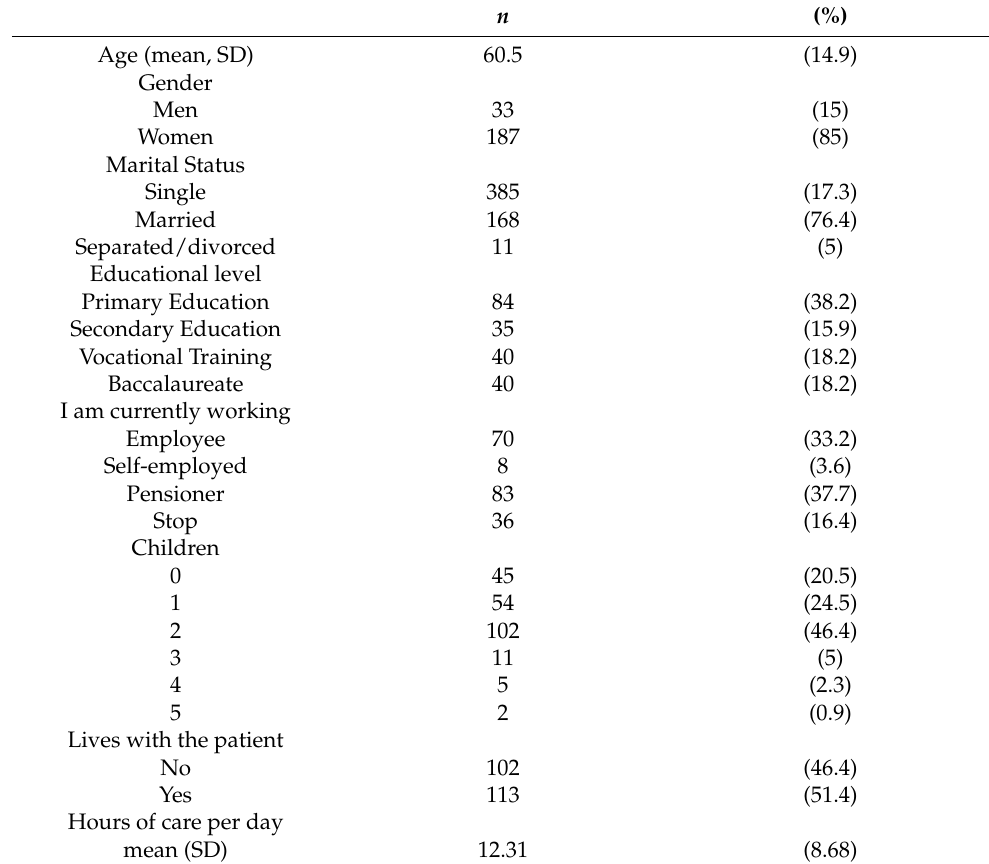
Table 1. Sample socio-demographic characteristics ( n =